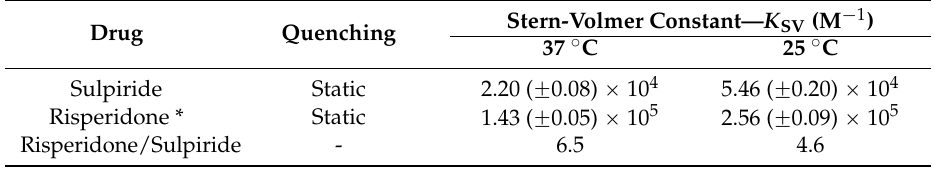
Table 1. Stern-Volmer Constant for risperidone and sulpiride with human serum albumin (HSA). Drug Quenching